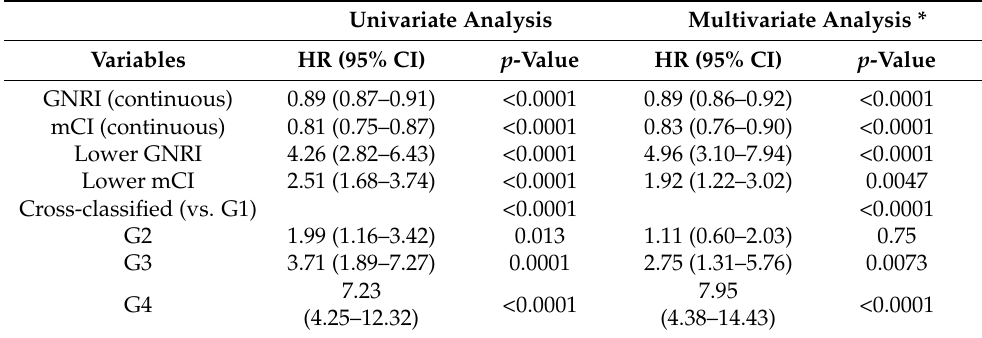
Table 2. Cox analysis of GNRI and mCI for all-cause